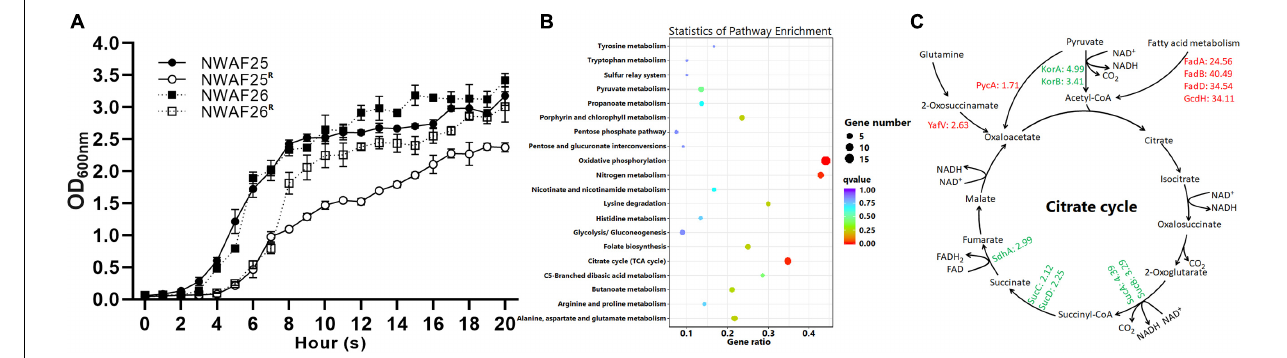
FIGURE 5 | The growth rate of S. sciuri and their oxacillin-resistant derivations. (A) Growth curves of NWAF25, NWAF26, NWAF25 R , and NWAF26 R isolates. Bacteria were grown at 37 ◦ C in TSB and OD 600 values were measured at 1-h interval for 20 h. (B) KEGG enrichment scatter map of downregulated differentially expressed gene of NWAF26 R compared with NWAF26. (C) The expression of genes related to energy production and bacterial growth was partially downregulated in NWAF26 R and highlighted with green color, the number represented the fold changes of regulation.